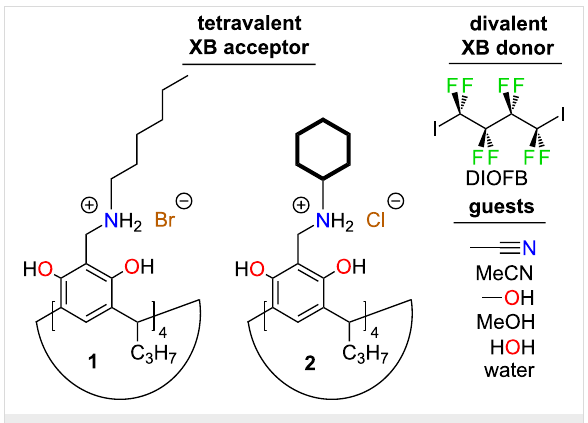
Figure 1: Tetravalent XB acceptor, Hex-NARBr 1 , Cy-NARCl 2 , diva- lent XB donor DIOFB, and guests MeCN, MeOH and